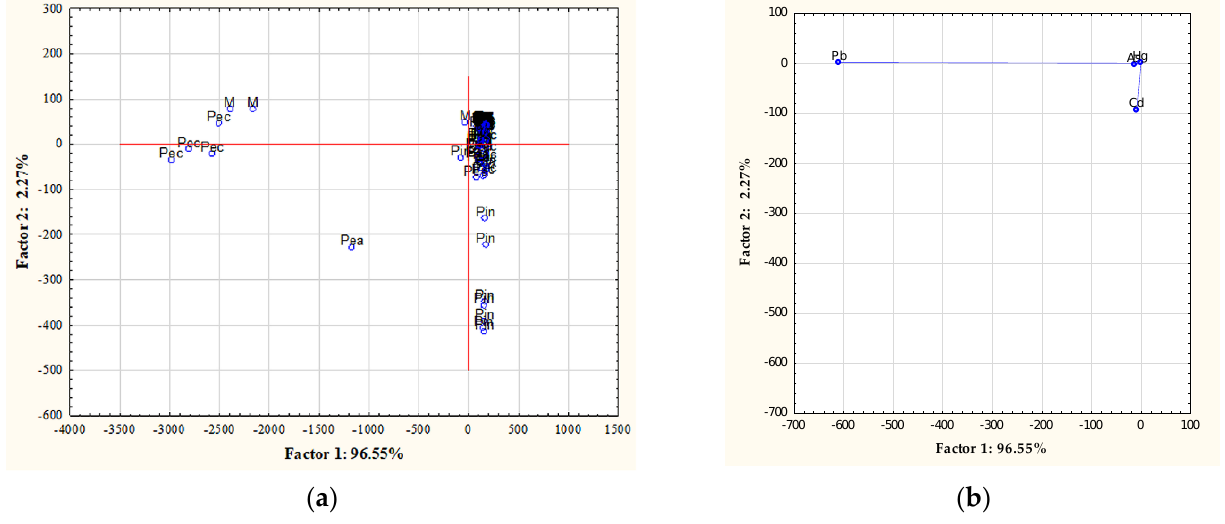
Figure 3. Two — dimensional plot of factor coordinates for cases ( a ) and variables ( b ). A — almonds; B — Brazil nuts; C — Figure 3. Two—dimensional plot of factor coordinates for cases ( a ) and variables ( b ). A—almonds; B—Brazil nuts; cashews; H — hazelnuts; M — macadamia; Pea — peanuts; Pec — pecans; Pin — pine; Pis — pistachio; W — walnuts. C—cashews; H—hazelnuts; M—macadamia; Pea—peanuts; Pec—pecans; Pin—pine; Pis—pistachio;